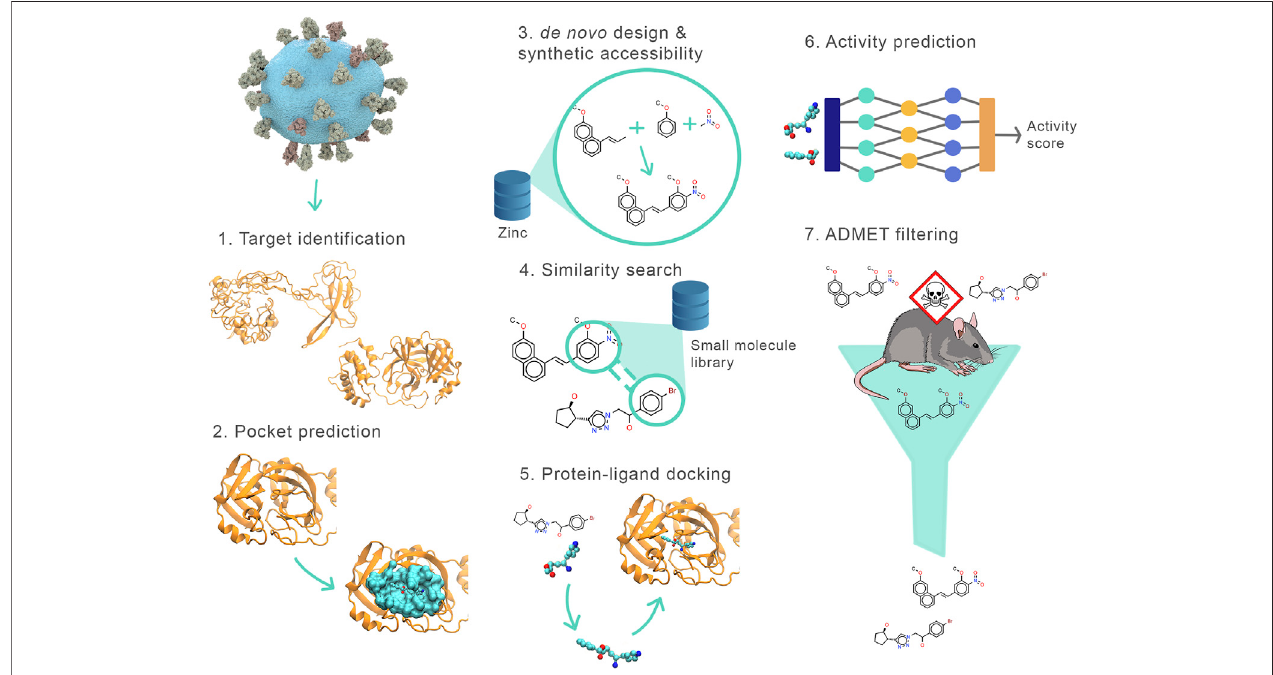
FIGURE1 | Outline ofthe drugsniffer virtual screening pipeline. The stages include (1) model thetargets(e.g., using AlphaFold or crystal structure where available), (2) identify possible binding sites/pockets (e.g., using FPocket), (3) design multiple de novo ligands for the target pockets using AutoGrow, (4) use the designed molecules as seeds to identify similar compounds from small-molecule libraries (using ECFP4 fi ngerprints as found in RDKit), (5) dock the molecules (using AutoDock Vina)identi fi ed bythe similarity search and calculatethe interaction energy between the target and thedocked poses, (6)re-scorethe best-dockedposes of all the molecules using our new scoring function (terms for the function are provided by SMINA and DLIGAND2), (7) identify potentially toxic compounds usingour fast ADMET analyzer (using FP-ADMET).